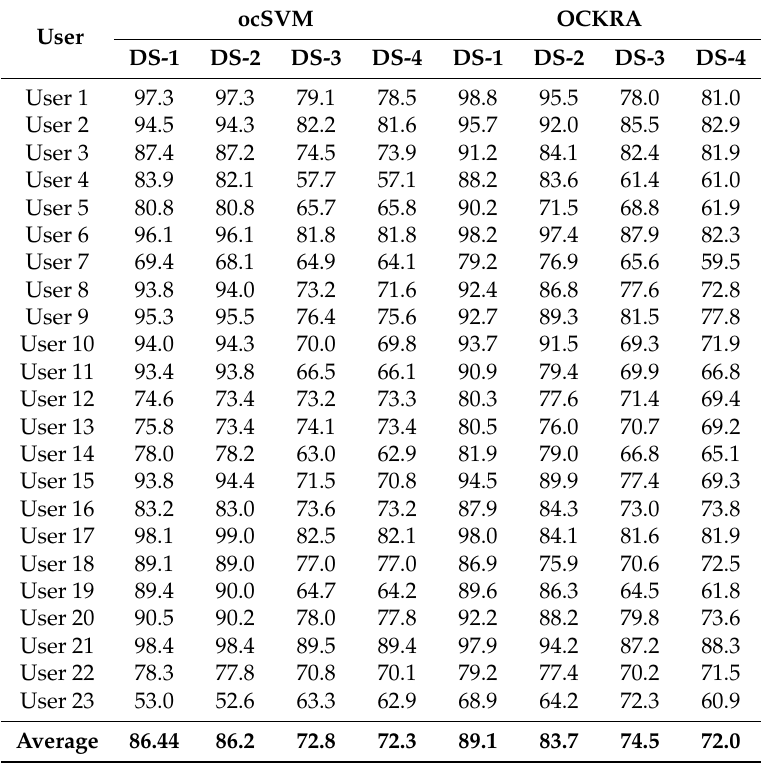
Table 8. ocSVM and OCKRA performance based on the AUC with different